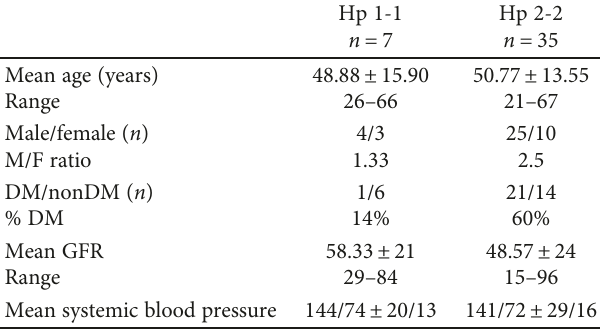
Table 1: Study participants ’ characteristics strati fi ed by Hp